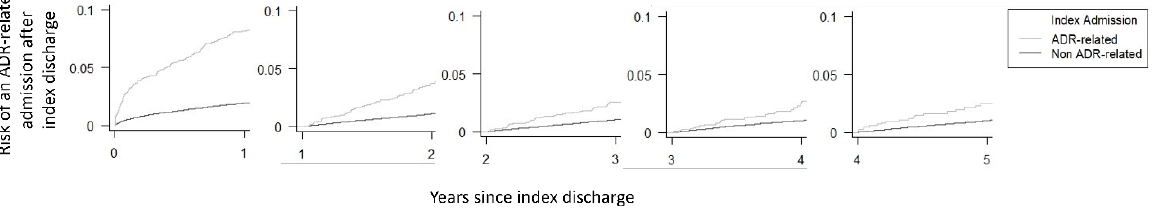
Figure A1. Risk of an ADR-related admission after index discharge for patients with ADR compared to non-ADR-related index admissions.